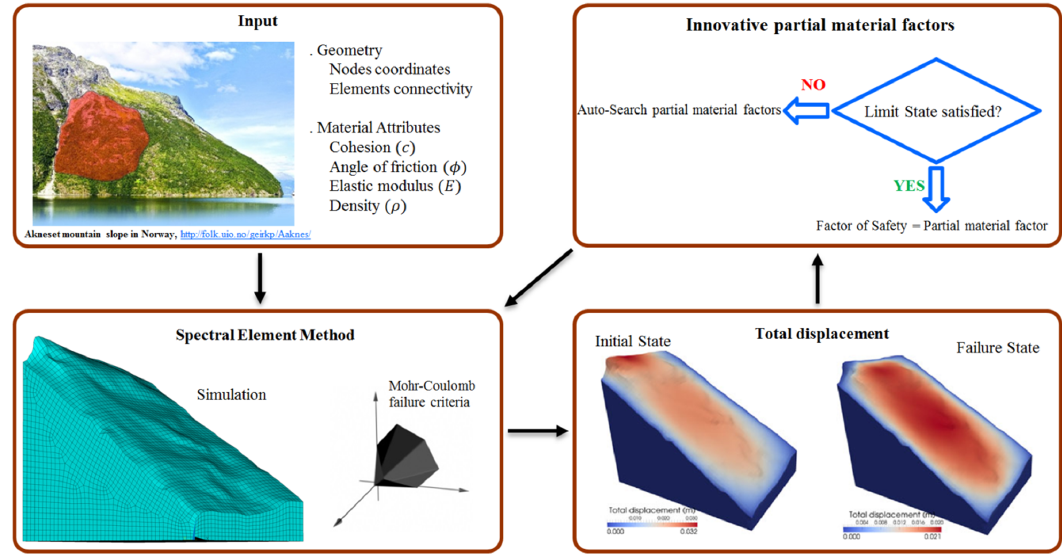
Figure 3. Landslide assessment